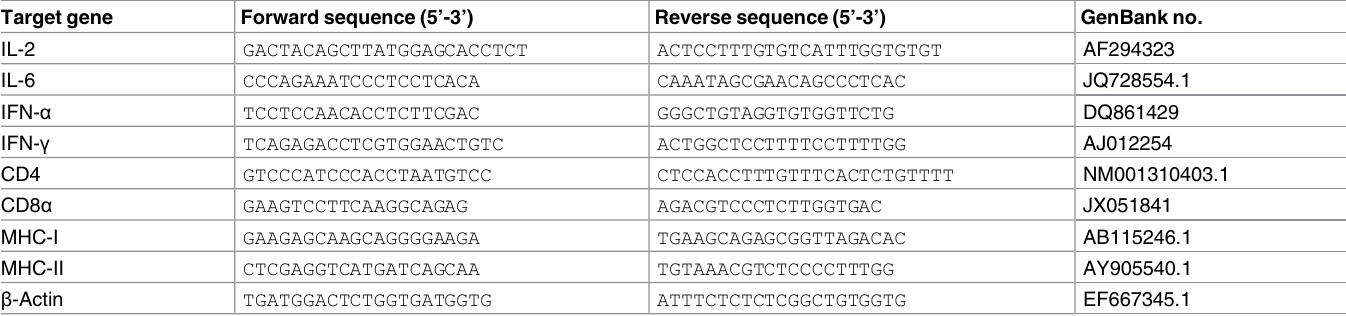
Table 1. Primers used in the quantitative real time PCR.